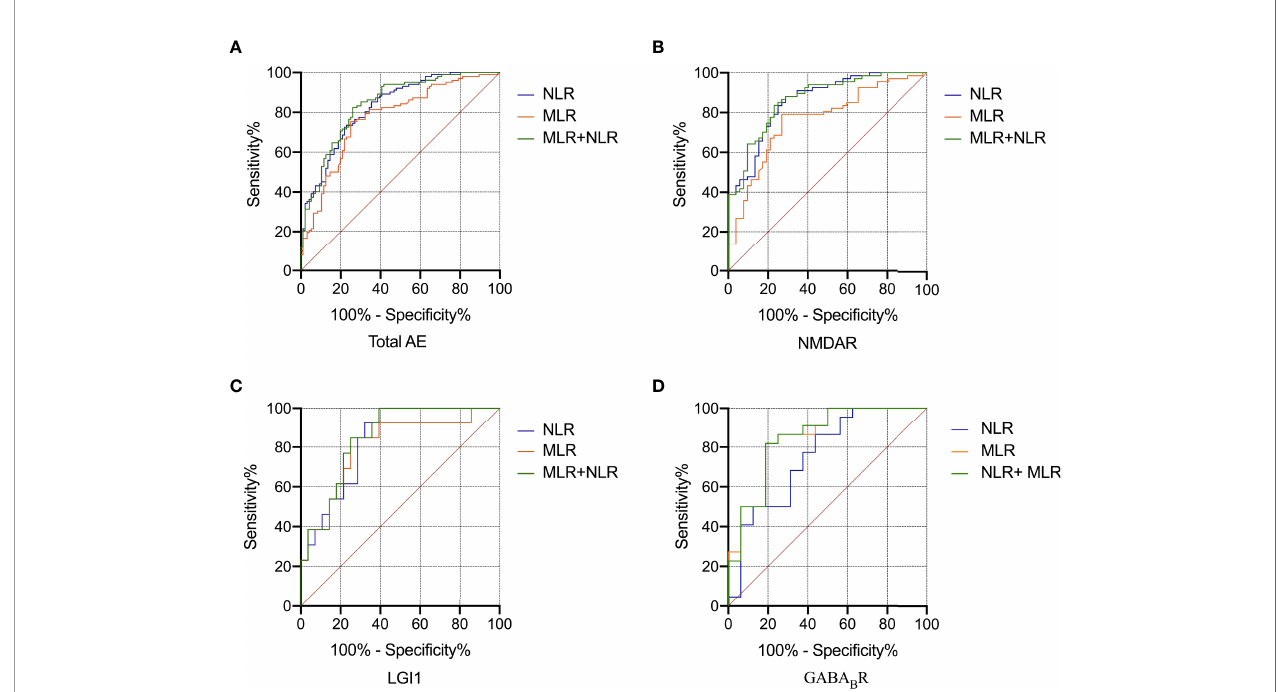
FIGURE 4 | ROC curve analysis of the predictive value of NLR and MLR for the severity of AE. Total AE, NMDAR, LGI1 and GABA B R (A-D) . AE, autoimmune encephalitis; NMDAR, N-methyl-D-aspartate receptor; LGI1, leucine-rich glioma inactivated 1; GABA B R, g -aminobutyric acid type B receptor; ROC, receiver operating characteristic; NLR, neutrophil-to-lymphocyte ratio; MLR, monocyte-to-lymphocyte ratio.